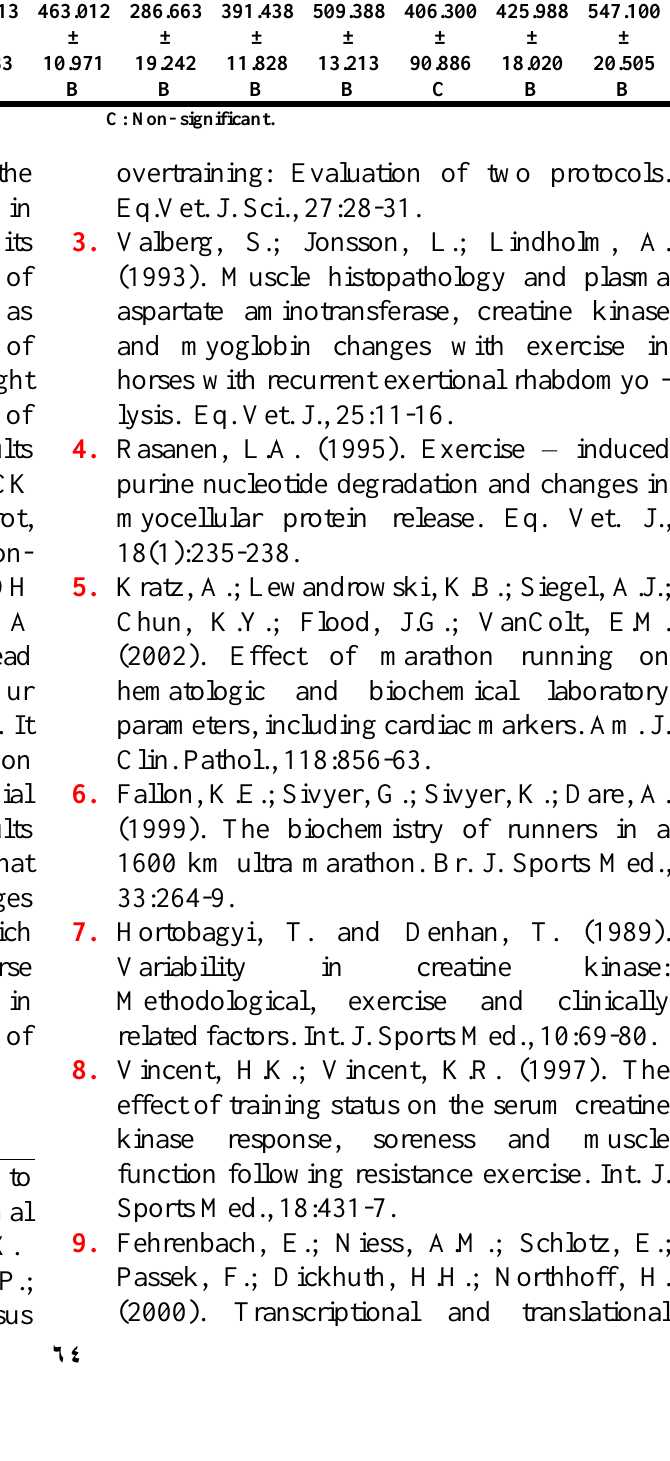
Gallop Canter Trot Walking